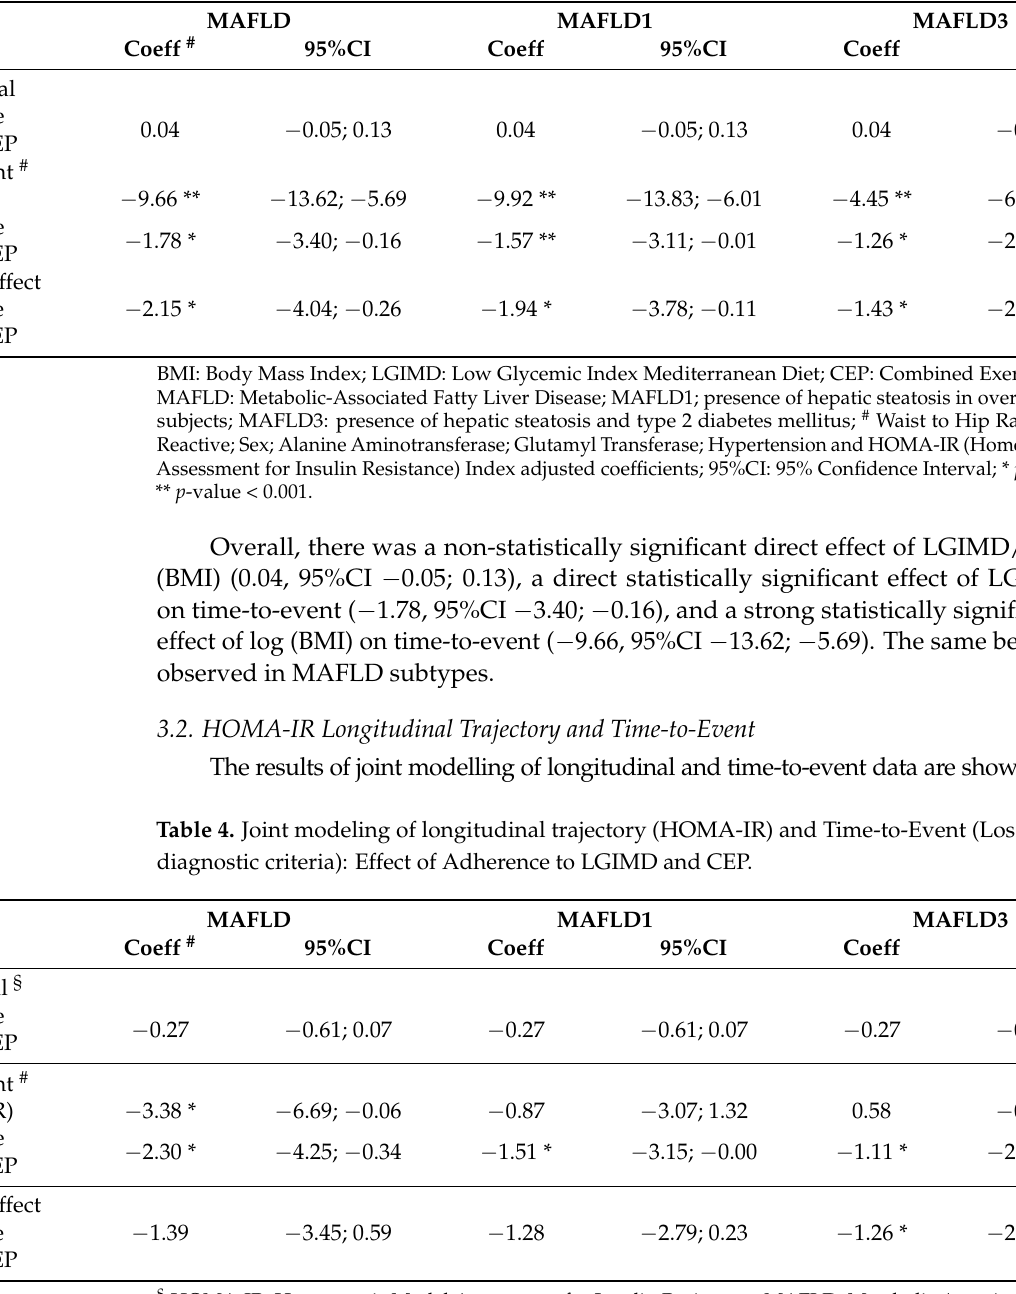
Table 3. Joint modeling of longitudinal trajectory (BMI) and Time-to-Event (Loss of MAFLD diagnos- tic criteria): Effect of Adherence to LGIMD and CEP.